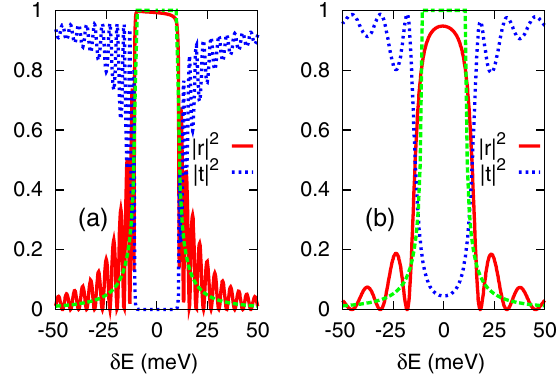
FIG. 3. Intensity reflectivity and transmittance for the diamond crystal C(4 4 4) in exact backscattering. The Bragg energy is near 12.4 keV. Part (a) plots the reflection (solid, red) and transmission (blue dotted) curves for a ‘‘thick’’ crystal with d ¼ 150 (cid:9) m , demonstrating no transmission with a slightly asym- metric reflection curve within the crystal bandpass. Outside the bandpass, the reflection curve oscillates about the absorption- free, d ! 1 curve (green, dashed line). Graph (b) plots the same curves for a ‘‘thin’’ crystal with d ¼ 42 (cid:9) m . The thin crystal reflectivity curve is rounded and decreased from the semi-infinite case, while the transmission j t j 2 (cid:3) 4 : 5% at (cid:10)E ¼ 0 . The com- plex phase of (a) and (b) is nearly identical to the ideal case (8) near the origin (cid:10)E ¼ 0